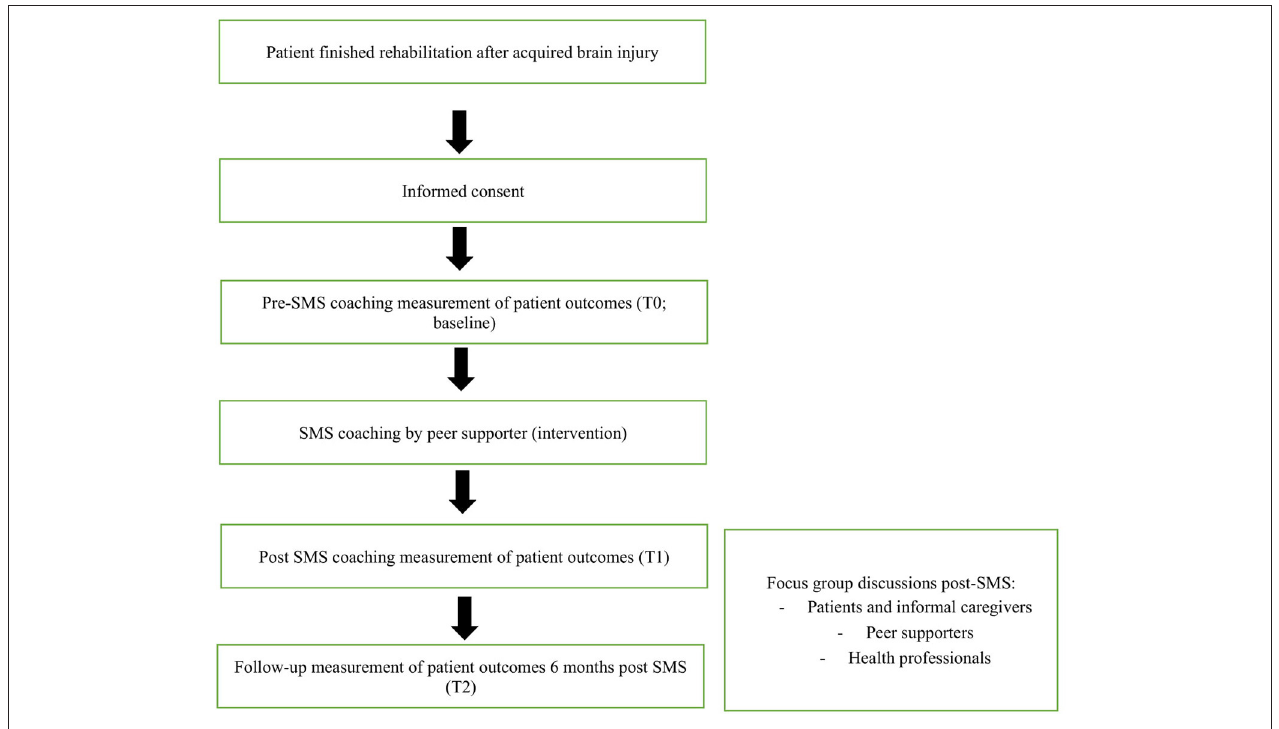
FIGURE 1 | Schematic representation of the study